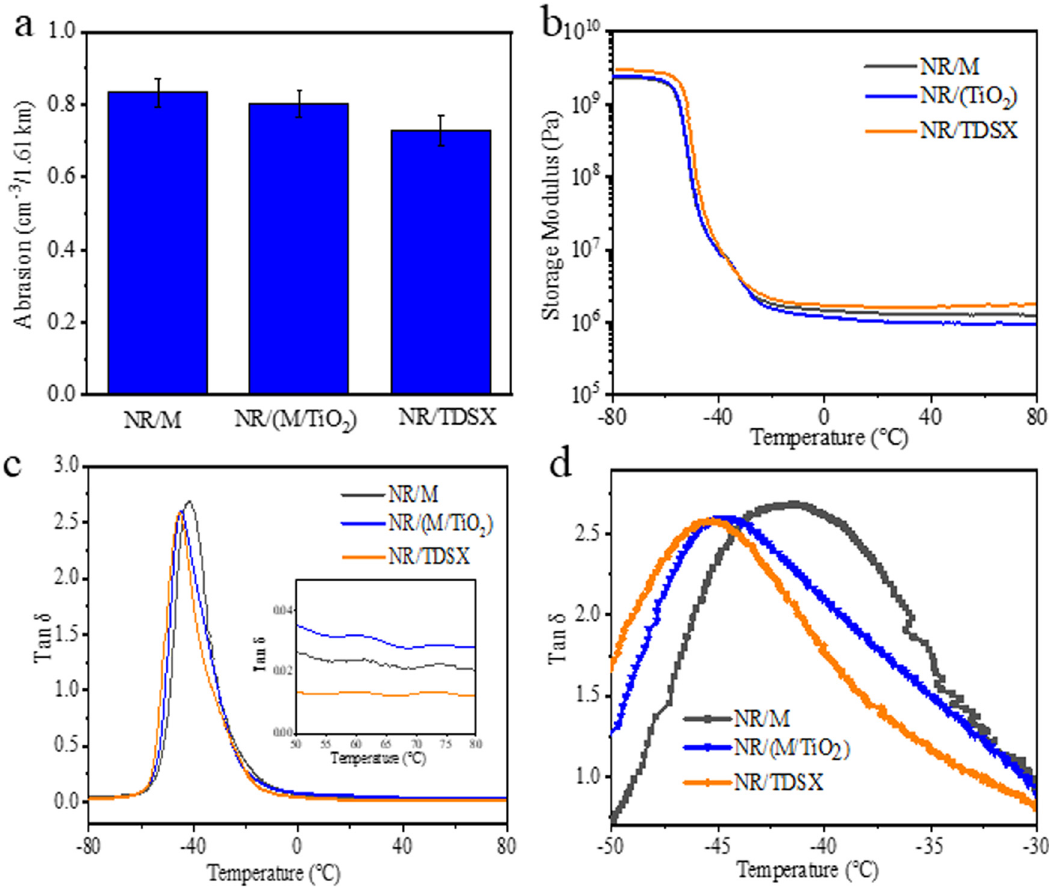
Figure 5: ( a ) abrasion of NR composites; ( b ) the storage modulus; ( c ) the tan δ curves; and ( d ) the high - de fi nition tan δ